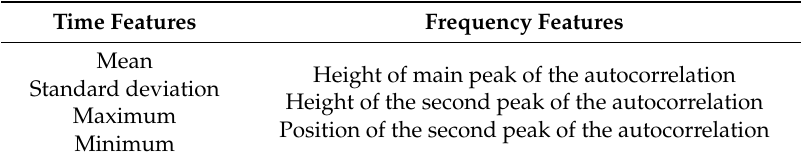
Table 2. List of features extracted from each stride of each acquired